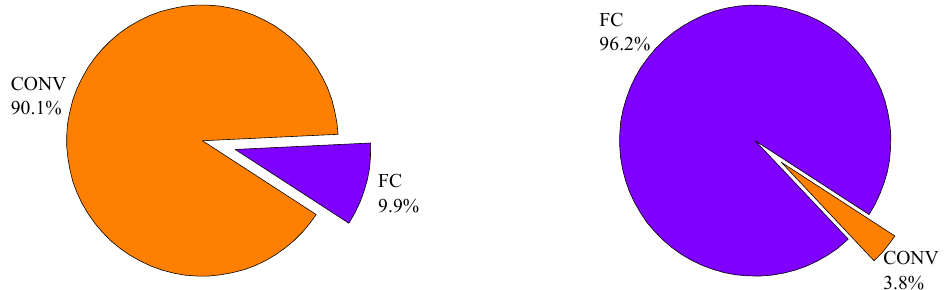
Figure 2. Unbalanced demand (the left) is for computation and memory (right) in AlexNet inference .